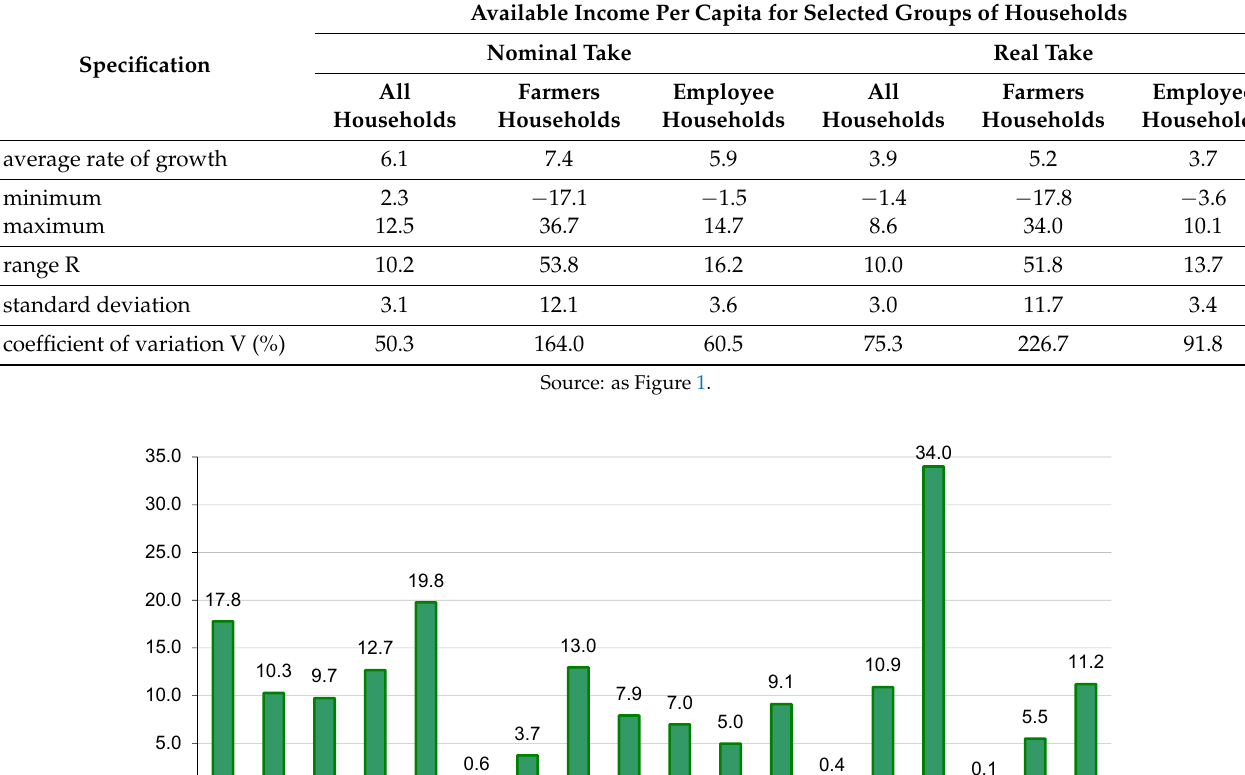
Figure 3. The absolute rate of change in the monthly nominal available income per capita in farmers’ households (in %). Source: as Figure 1.